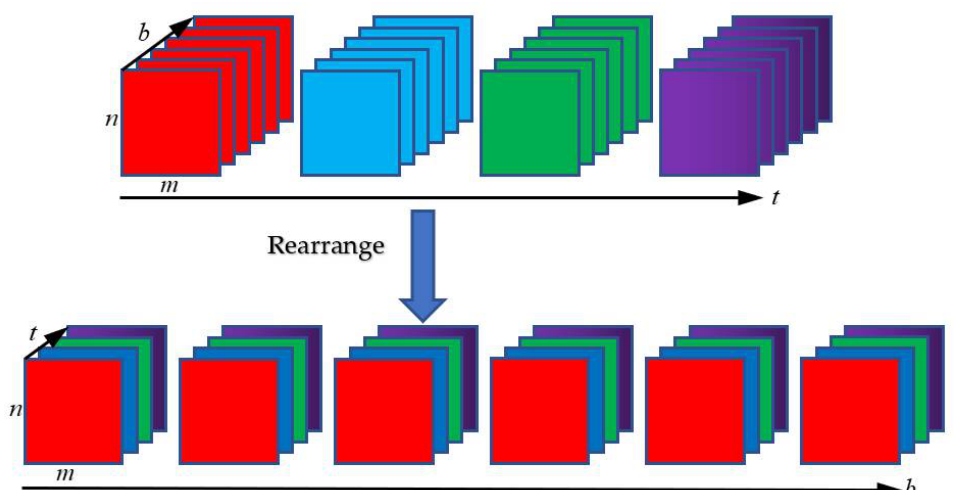
Figure 1. Multi-temporal remote sensing images rearrangement.